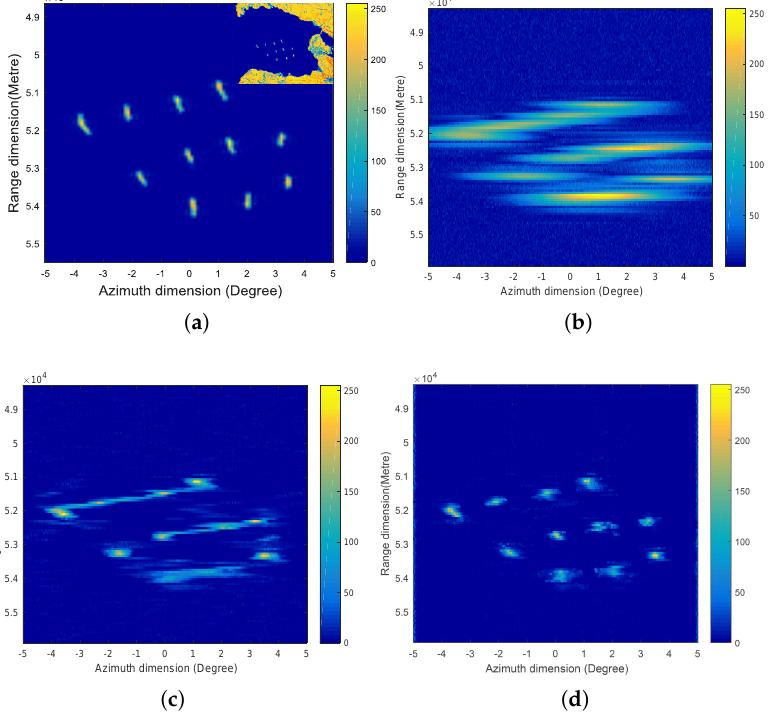
Figure 5. Simulation results of scene when the SNR and signal to clutter ratio (SCR) are 20 dB and 15 dB, respectively. ( a ) Original scene. ( b ) Real beam image after pulse compression and motion compensation. ( c ) Superresolution result processed by the Poisson-based MAP algorithm. ( d ) Superresolution result processed by the proposed sparse Bayesian algorithm.